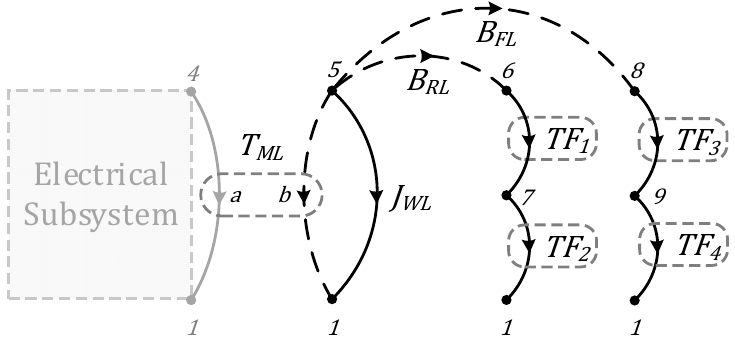
Figure 6. Simplified LG model and the normal tree of the left-side drivetrain subsystem. The equations produced by the LGtheory toolbox for the simplified drivetrain subsystem based on the constitutive equations and normal tree of the LG model are as follows. The continuity equations for each passive branch